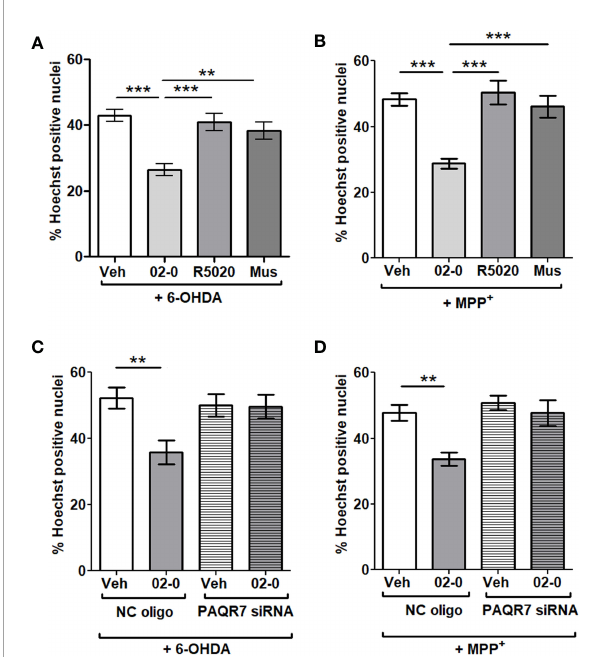
FIGURE 2 Investigation of the possible contribution of different progestogen receptors in P4 neuroprotection in SH-SY5Y cells (A) Assessment of cell death in SH-SY5Y cells following Veh, 100 nM 02-0, 100 nM R5020 and 100 m M Mus (muscimol) 24 h treatments in presence 50 m M 6-OHDA. N=18. One-way ANOVA results: p<0.0001. Tukey ’ s multiple comparisons test results: **: p<0.01: ***: p<0.001. (B) Assessment of cell death in SH-SY5Y cells following Veh, 100 nM 02-0, 100 nM R5020 and 100 m M Mus (muscimol) 24 h treatments in presence of 750 nM MPP + . N=18. ***: p<0.001. (C) Assessment of cell death in SH-SY5Y cells following Veh and 100 nM 02-0 24 h treatments in presence of 50 m M 6-OHDA and following PAQR7 (mPR a ) gene silencing. N=18. Two-way ANOVA results: Interaction: p=0.0274, Treatment: p=0.0196, Silencing: p=0.1006. Bonferroni ’ s post-test results: **: p<0.01. (D) Assessment of cell death in SH- SY5Y cells following Veh and 100 nM 02-0 24 h treatments in presence of 750 nM MPP + and following PAQR7 gene silencing. N=18. Two-way ANOVA results: Interaction: p=0.0514, Treatment: p=0.0033, Silencing: p=0.0036. Bonferroni ’ s post-test results: **: p<0.01.